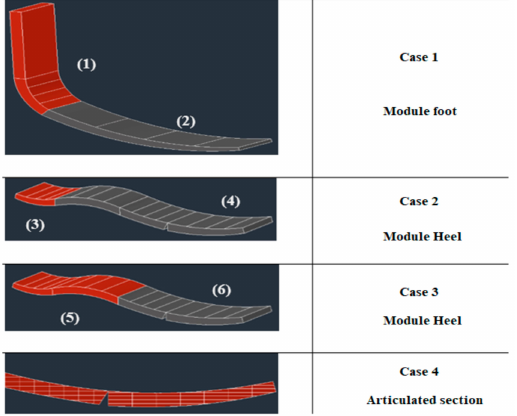
Figure 7. Study cases of prosthesis modules for the analytical method.